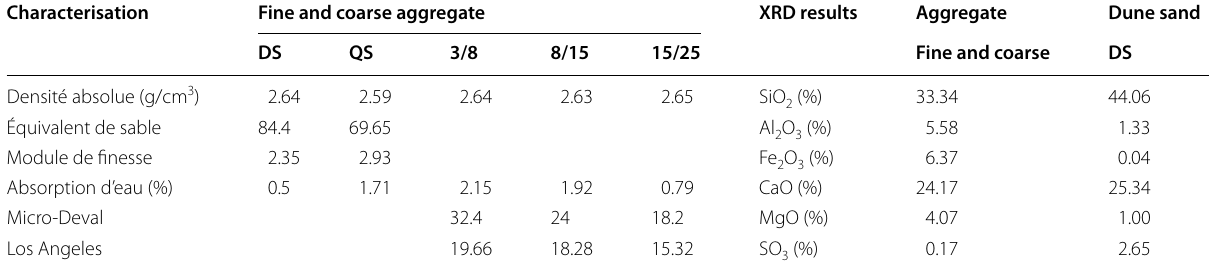
Table 2 Characteristics of aggregates—results of XRD analysis.